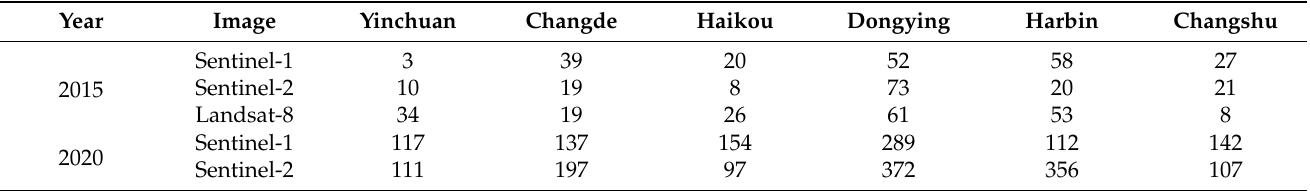
Table 2. The number of remote sensing images of 6 cities in 2015 and